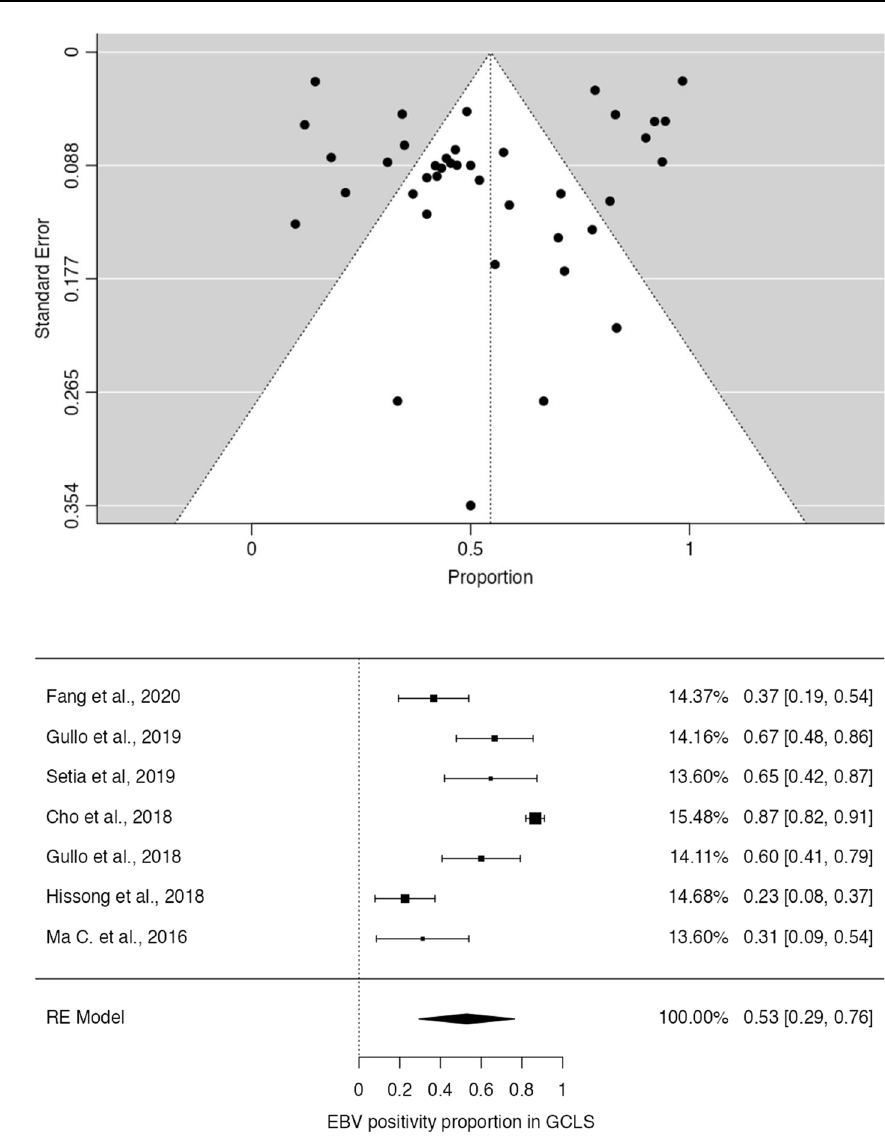
Fig. 5 Funnel-plot on the proportion of the included patient sets